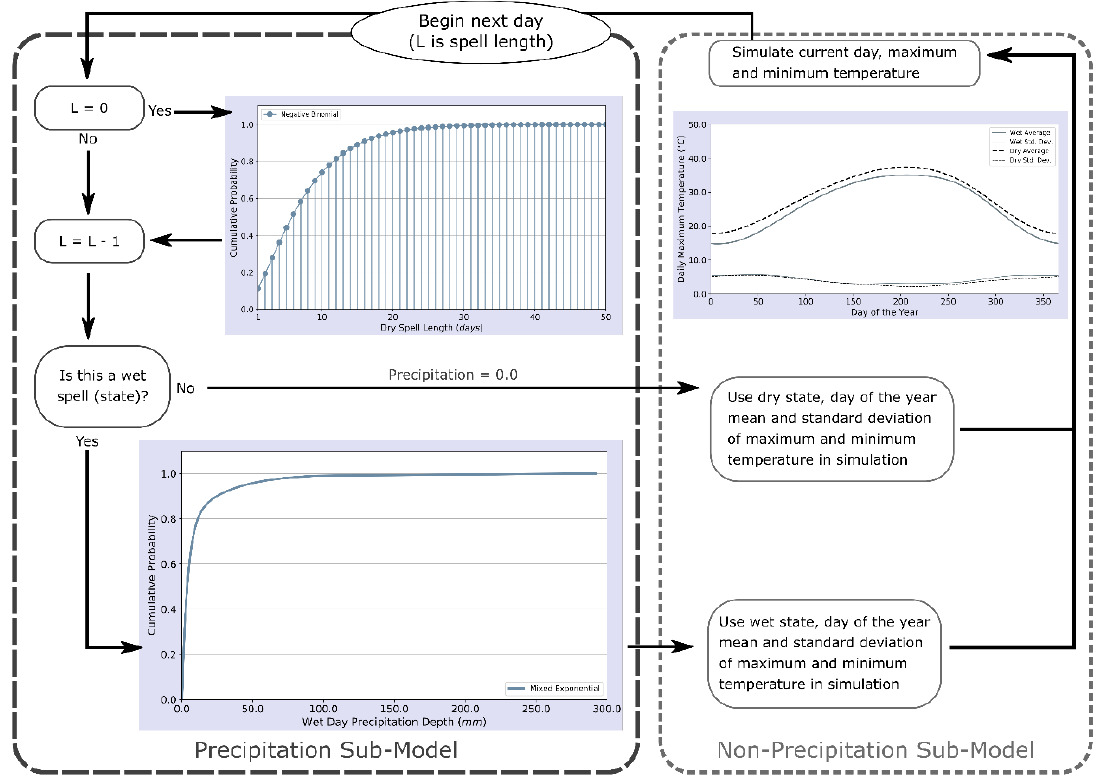
Figure 4. Schematic of weather generator implementation. Weather generators provide for stochastic simulation of precipitation occurrence and intensity and maximum and minimum daily temperature. An alternating state, spell length approach based on negative binomial distributions provides the precipitation occurrence process representation. Precipitation intensity is represented with daily, wet state precipitation depth sampled from mixed exponential distributions. Simulated air temperature is conditioned on state and calculated with a first-order vector autoregression.